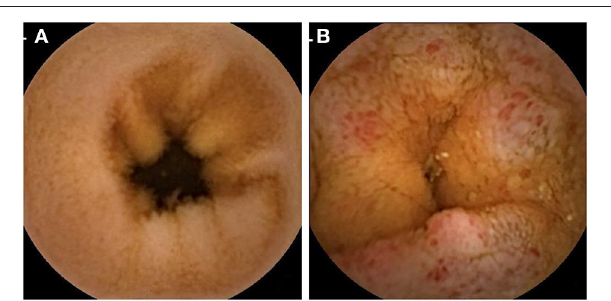
FIGURE 1 | Representative capsule endoscopic images. (A) Normal small intestine of normotensive participants; (B) Mucosal edema (enlarge villi) and moderate to severe mucosal hyperemia (area of reddish villi) were observed in the small intestine of patients with hypertension.